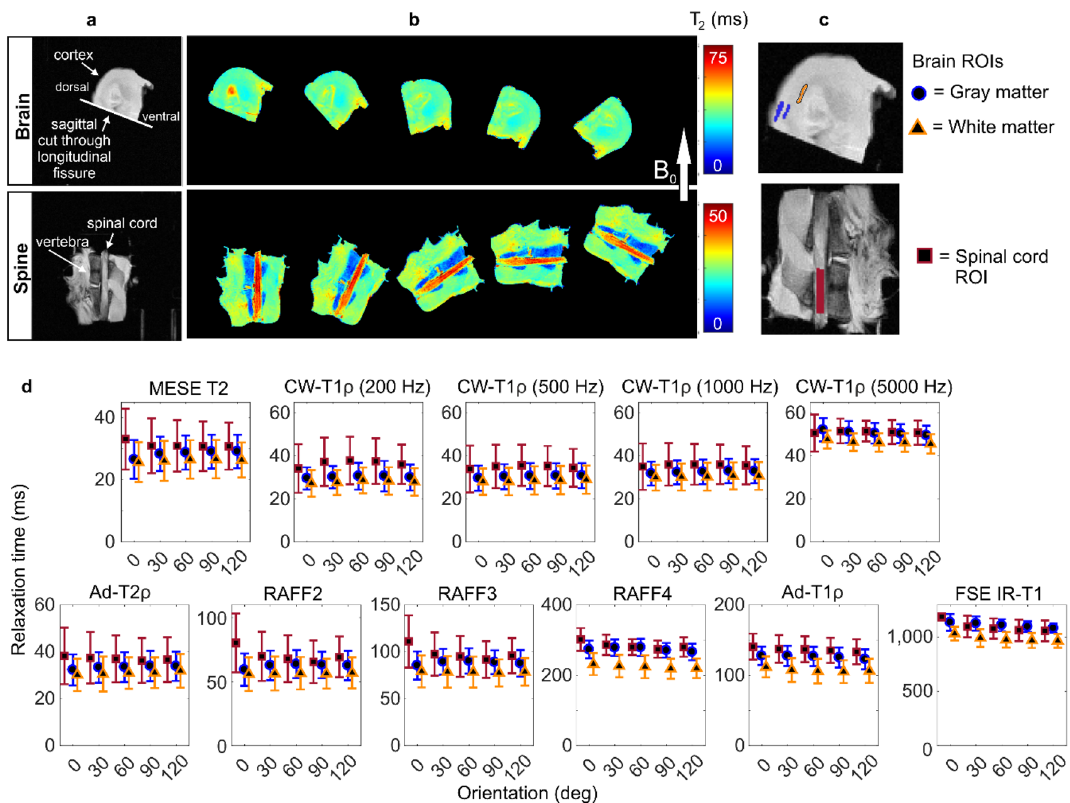
Figure 3. Brain and spinal cord: ( a ) T2-weighted images and ( b ) T2 maps at the five measured orientations of representative samples. ( c ) Definition of ROIs. ( d ) Average relaxation times of four samples at the five orientations (0–120 deg) for the defined ROIs in brain and spinal cord